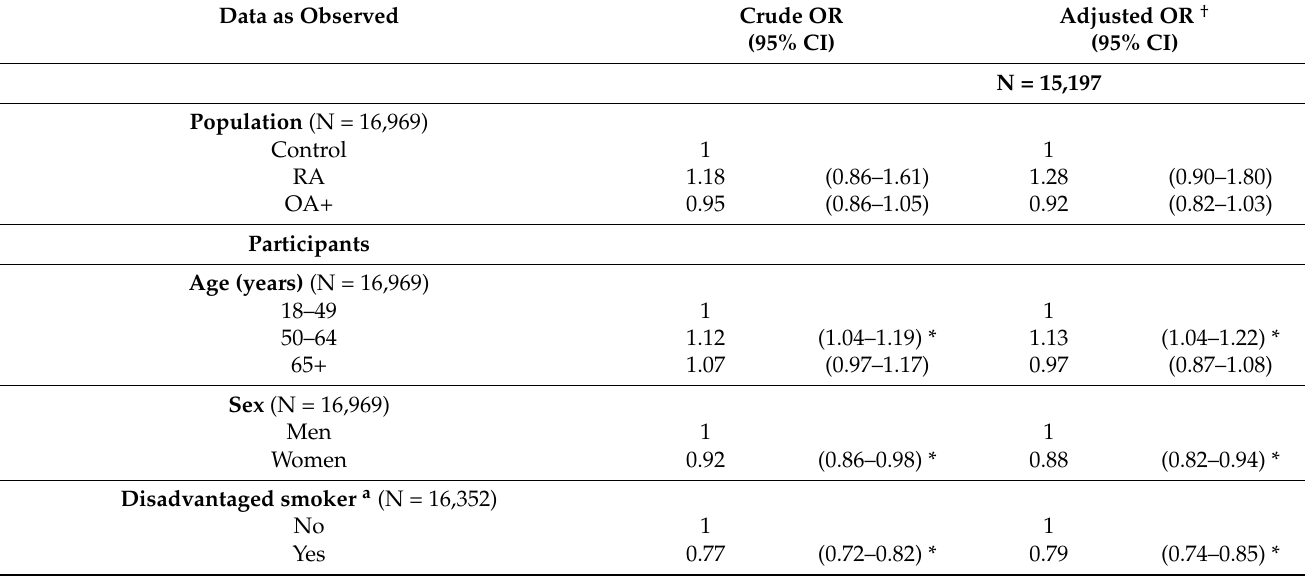
Table 2. Odds ratio (OR) for predictors of continuous abstinence at six months. Multivariable analysis is adjusted for age, sex, being disadvantaged, heavy smoking, previous quit attempts, living with a smoker, format, compliance to the GSP, and smoking cessation clinic.